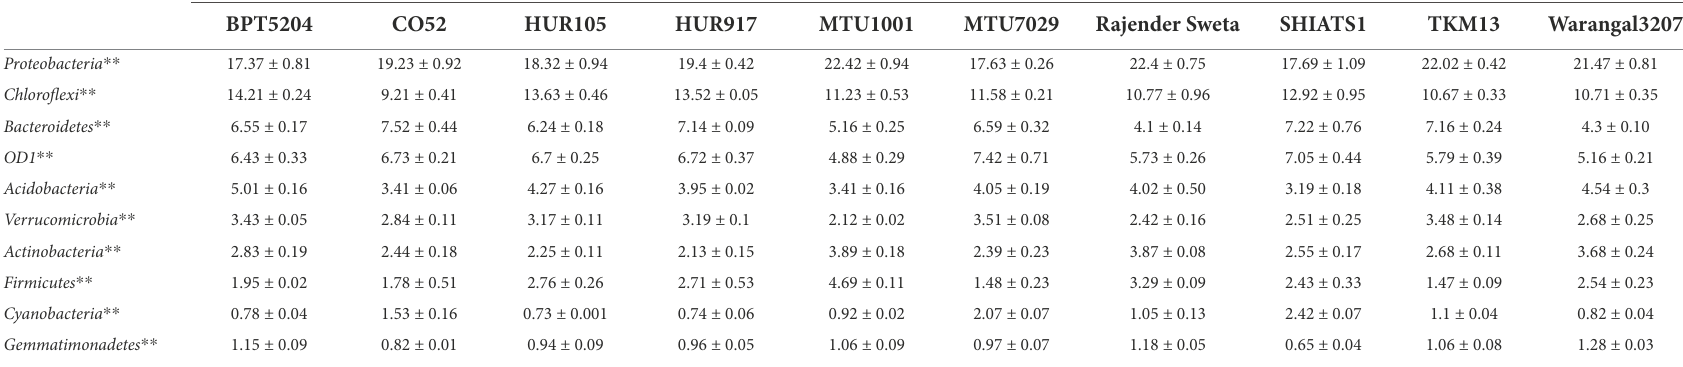
TABLE 1 Mean relative abundance (%) of top 20 bacterial phylum associated with rhizo-microbiome of the rice varieties.